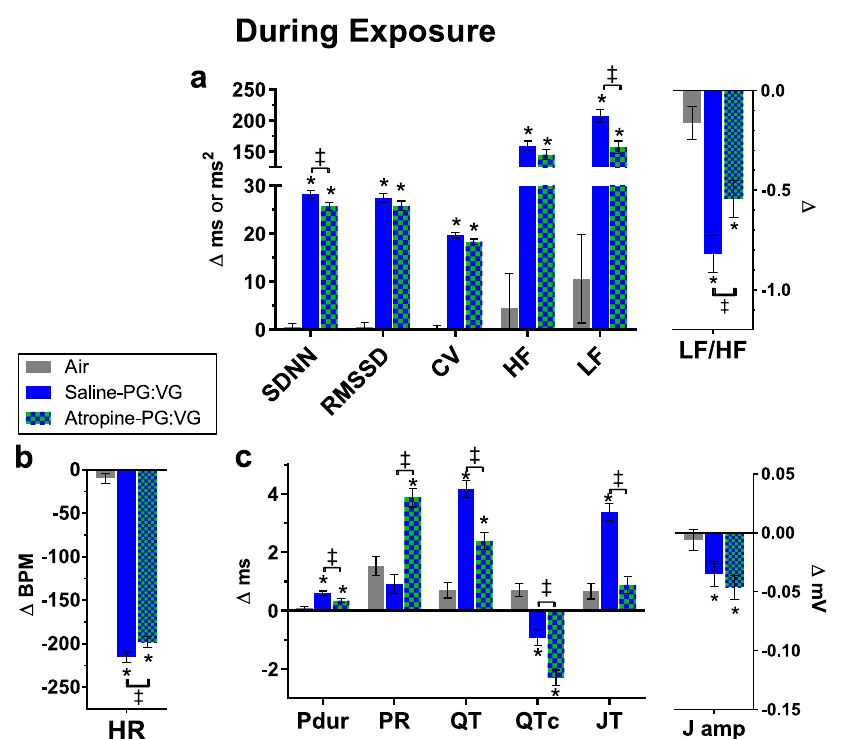
Fig. 9 | Muscarinic receptor blockade alters electrophysiologicand autonomic effects of E-cig aerosols during exposure. Bars represent least square means (±SEM) of change from 5-min baseline during exposure ( n =6/exposure) in HRV indices ( a ), heart rate ( b ), and ECG morphology ( c ). Signi fi cance determined by two-sided P <0.05 (vs. Air: asterisk; atropine-PG:VG vs. Saline-PG:VG: two-barred